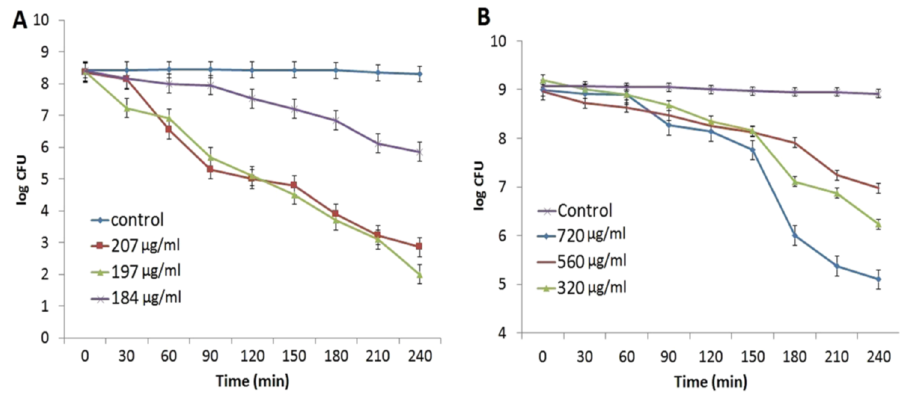
Figure 9. Killing kinetics of K. pneumoniae AWD5 exposed to ( A ) spherical AgNPs at concentrations of 184–207 μg/mL and ( B ) rod-shaped AgNPs at 320–720 μg/mL. Results were expressed as means ± SD;